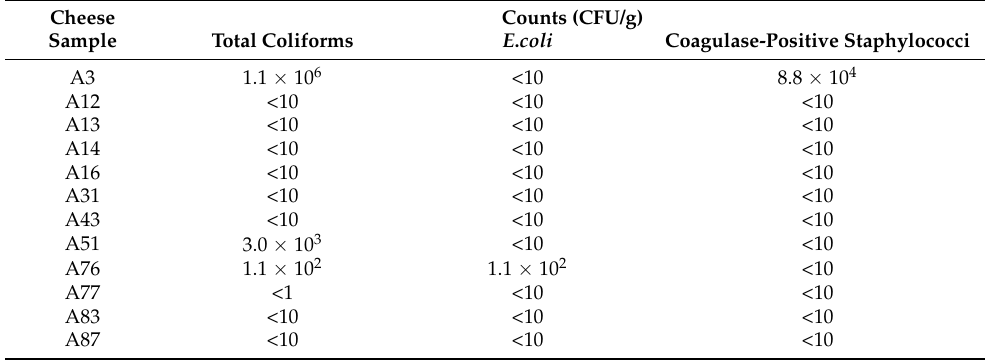
Table 3. Hygiene indicators in Listeria monocytogenes -positive Minas artisanal cheese samples. Cheese